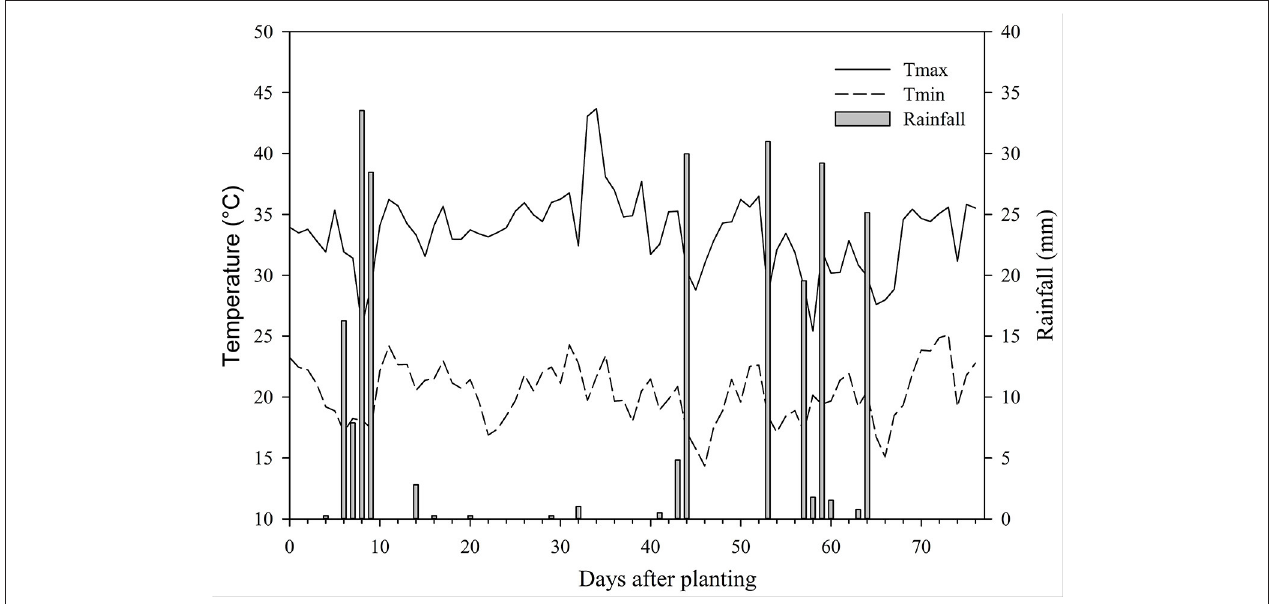
FIGURE 1 | Daily maximum (Tmax) and minimum (Tmin) temperatures and rainfall encountered during the summer growing season of 2018 at El Reno, Oklahoma, USA.